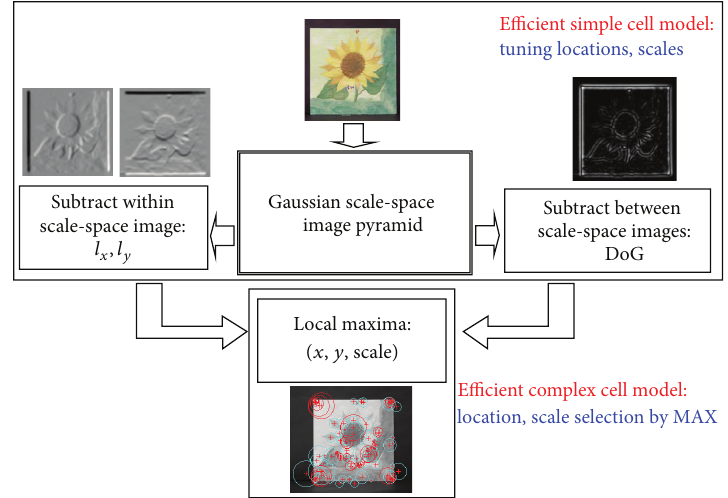
Figure 6: Procedure for the visual part detection: convex and corner parts are detected.